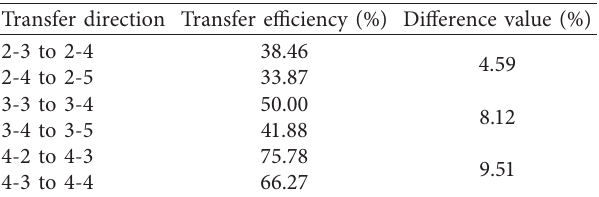
Table 5: HSTEs in the transfer zone and in the free zone. Transfer direction Transfer efficiency (%) Difference value